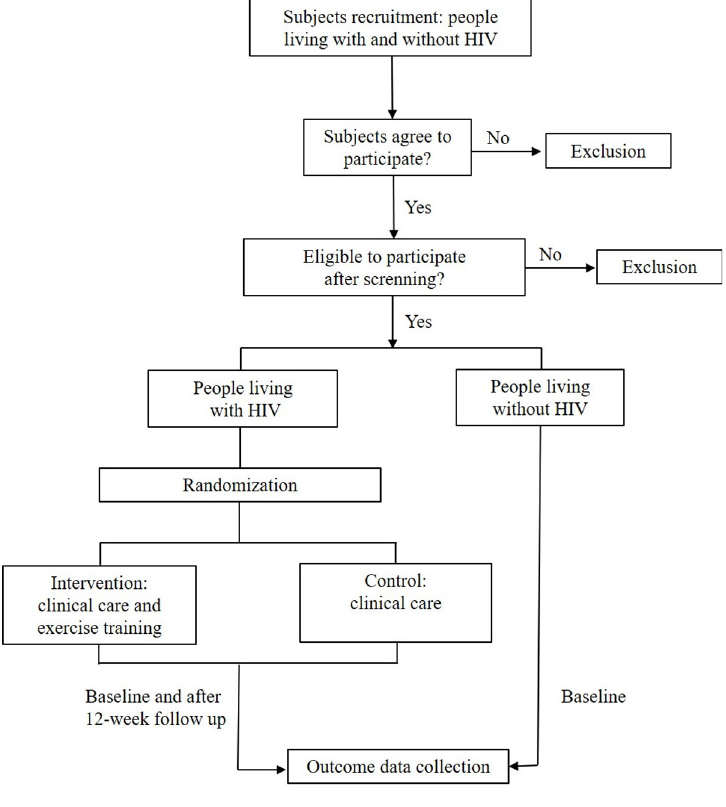
Fig 2. Study flowchart.